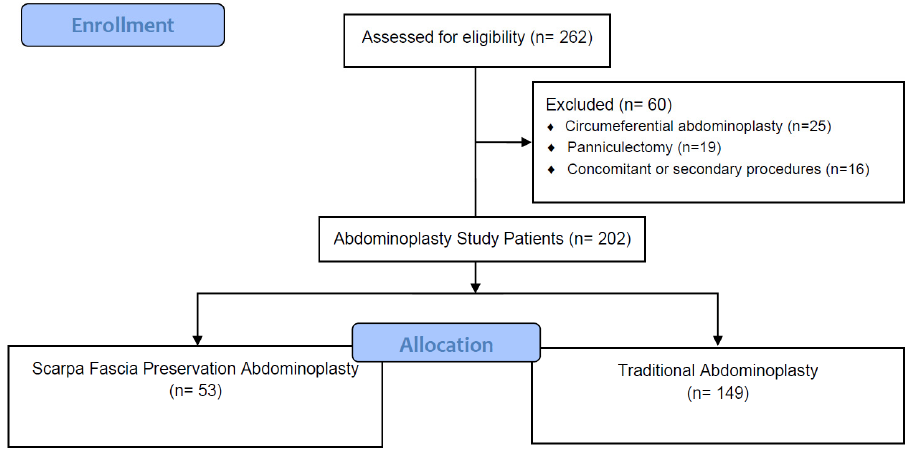
Figure 2. Flowchart of the study. Table 1. Demographics of patients at the time of the study.